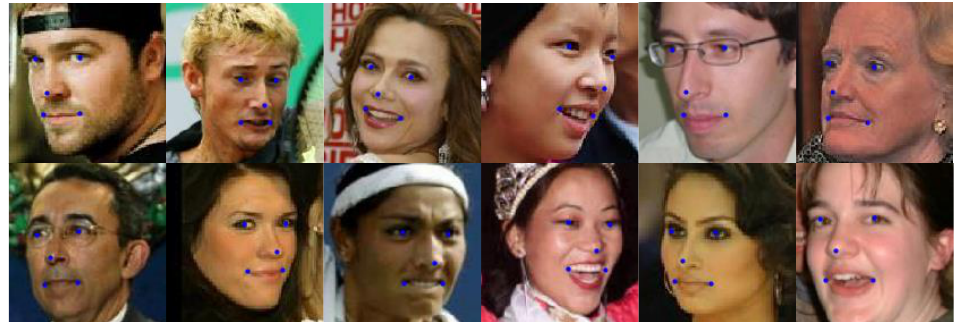
Figure 4. Some detection results of faces with large pose and expression variations. The face images are from LFW+Webface. First row: results by ACN. Second row: results by 1-bit ACN. Both of the two models use the 20-40-60-80 kernel